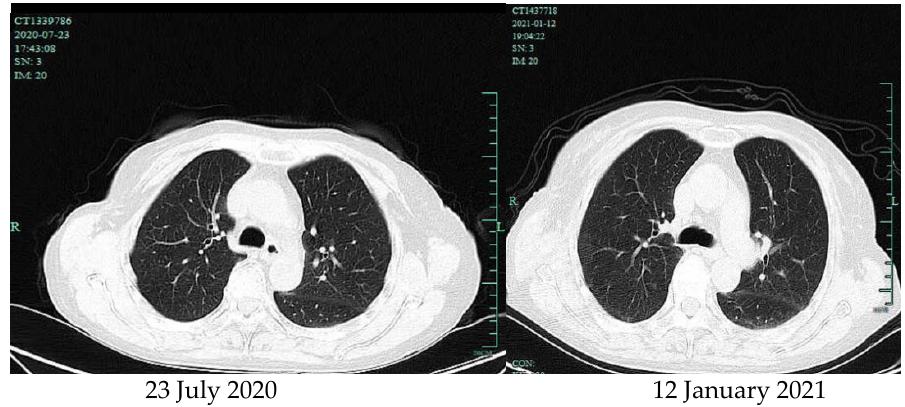
Figure 4. Chest computed tomography.